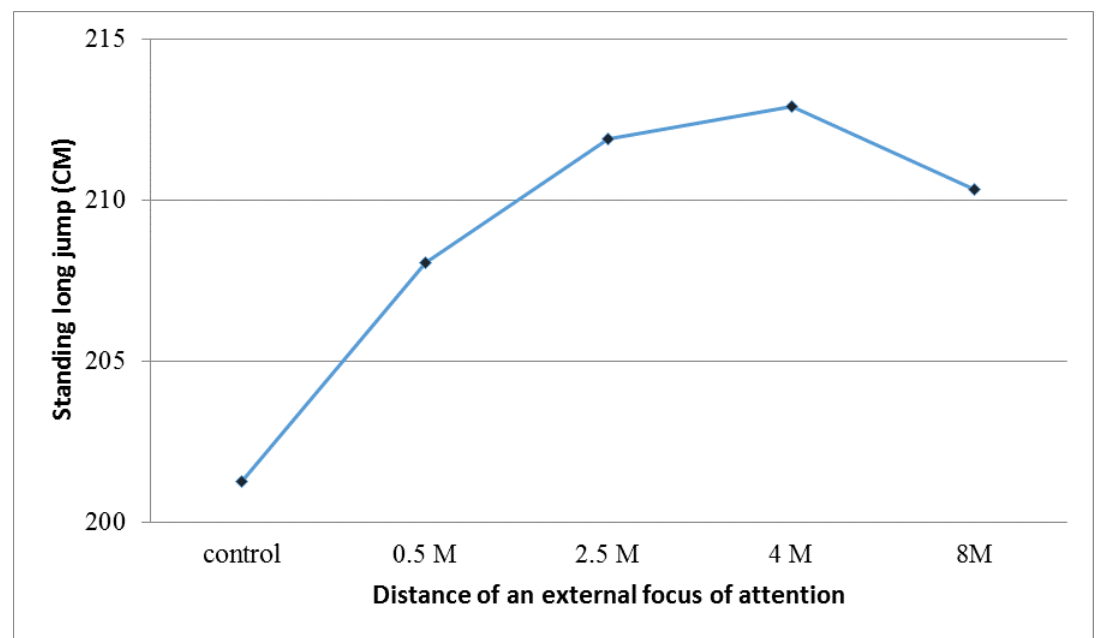
Figure 1: Participants’ performance at different conditions of attention